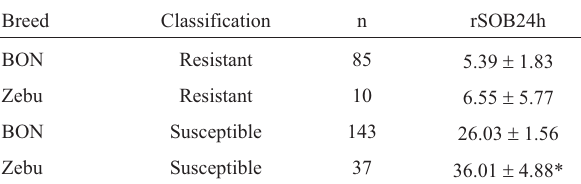
Table 3 - Intracellular growth of B. abortus in vitro after 24 h (rSOB24h) in resistant and susceptible breeds of cattle (BON: Blanco Orejinegro Creole; Zebu: Brahman).